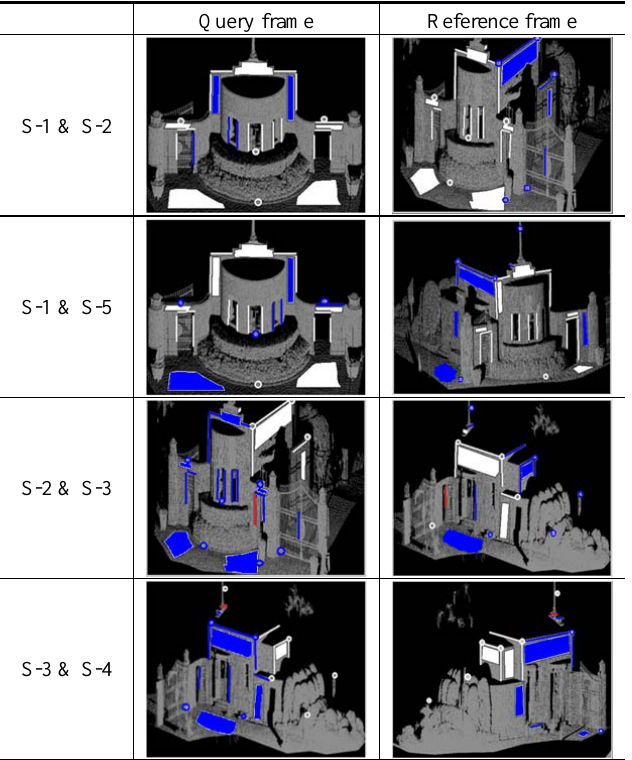
Table 3. the visual inspection of matching